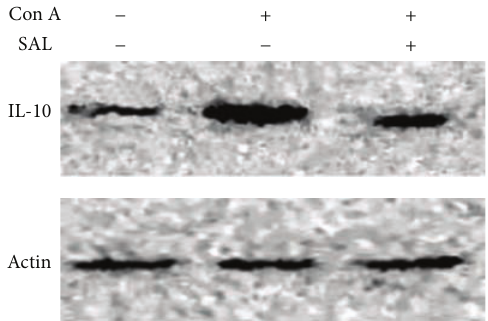
Figure 9: The effect of salidroside pretreatment on IL-10 protein expression. Salidroside pretreatment followed Con A administration attenuated IL-10 protein expression in the liver.